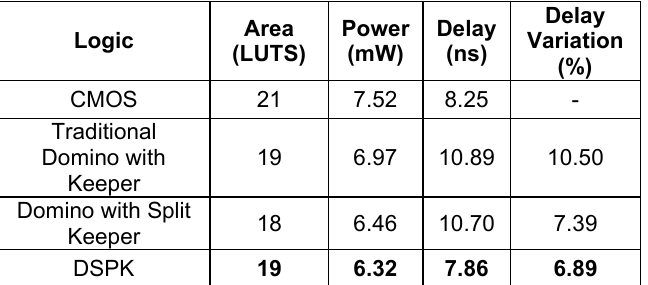
Table 4. Circuit Analysed: NOR2